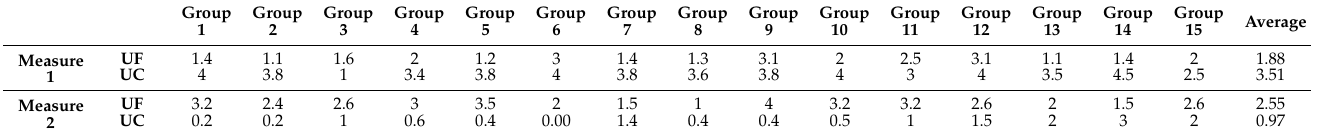
Table 11. Measures of shared knowledge and the discrepancy in knowledge in UC vs UF (post).